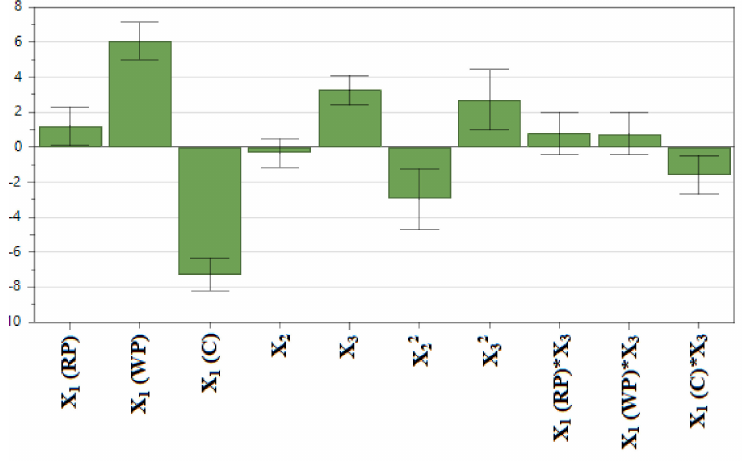
Figure 2. The factors influencing TPC. X 1 : plant material, RP: red pomace, WP: white pomace, C: canes, X 2 : ethanol ratio, X 3 :